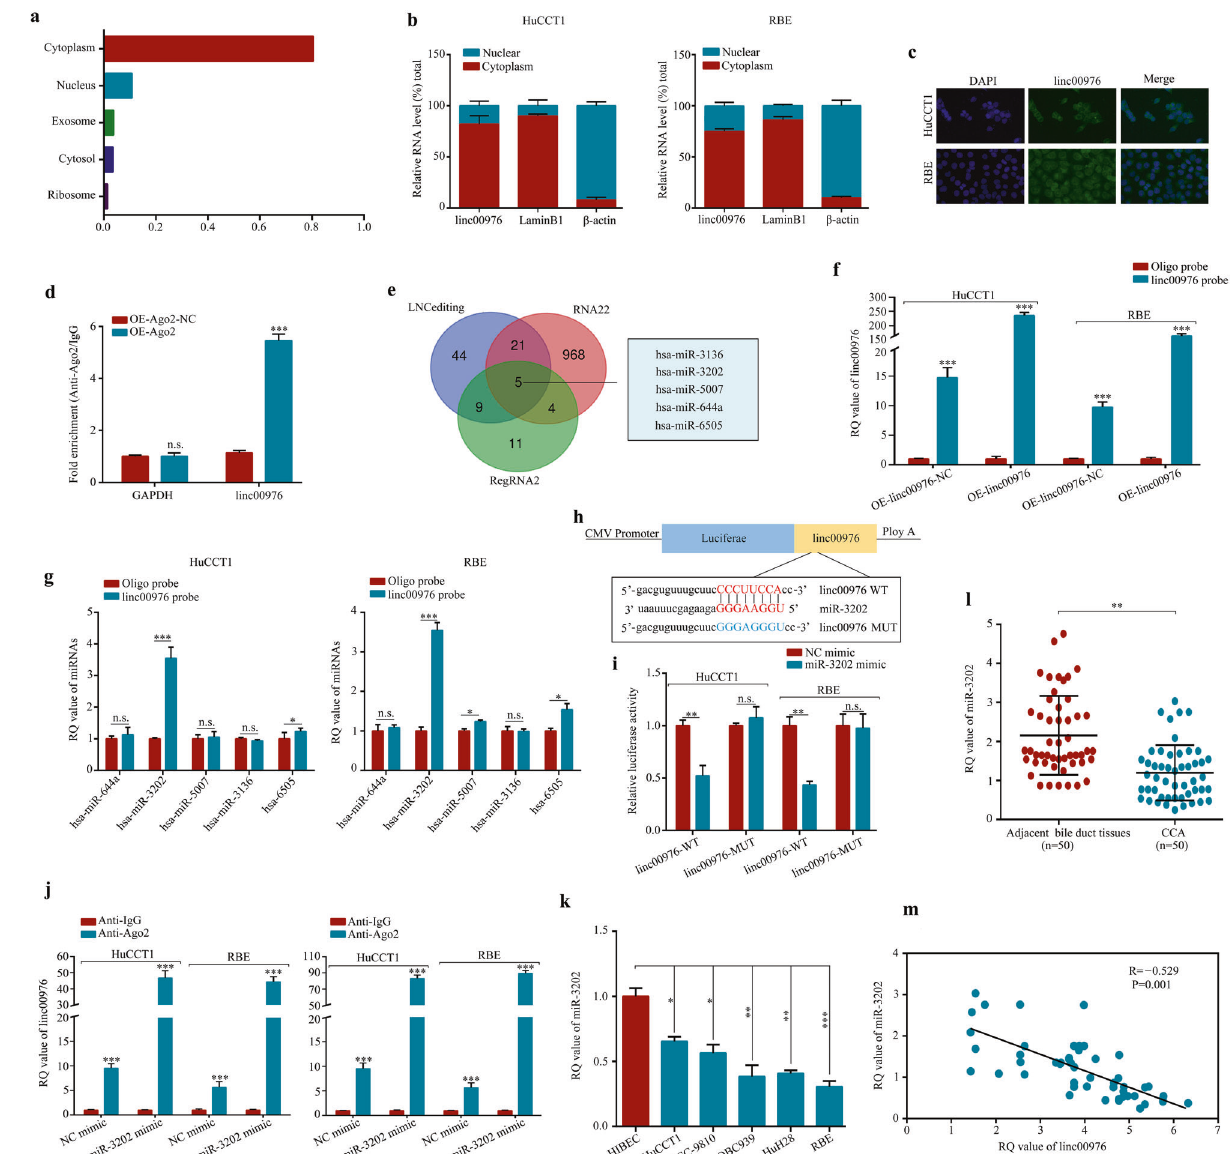
e Schematic illustration showing overlapping target miRNAs of linc00976 predicted by LNCediting, RegRNA2, and RNA22. f Lysates prepared from CCA cells transfected with linc00976-overexpression vectors or control vectors were subject to RNA pull-down assay, and the ef fi ciency was con fi rmed by RT-qPCR. g The relative levels of fi ve miRNA candidates in the CCA cell lysates were examined by RT-qPCR. h The putative binding sites between miR-3202 and linc00976. i The luciferase activities was detected in CCA cells after co-transfection with linc00976-WT or linc00976-MUT and miR-3202 mimics or NC mimics. j Anti-Ago2 RIP assay was conducted in CCA cells after transfection with miR-3202 mimics or NC mimics, followed by western blotting and RT-qPCR analyses to detect the expression levels of Ago2, linc00976, and miR-3202. k Relative expression level of miR-3202 in CCA cells and human intrahepatic biliary epithelial cells. n.s. not signi fi cant, * P < 0.05, ** P < 0.01, *** P < 0.001. l The expression level of miR-3202 was detected by qRT-PCR in 50 paired CCA tissues and adjacent non-tumor tissues. m Pearson correlation analysis of linc00976 and miR-3202 expression in 50 CCA tissues. CCA cholangiocarcinoma, ISH in situ hybridization, RT-qPCR reverse transcription-quantitative